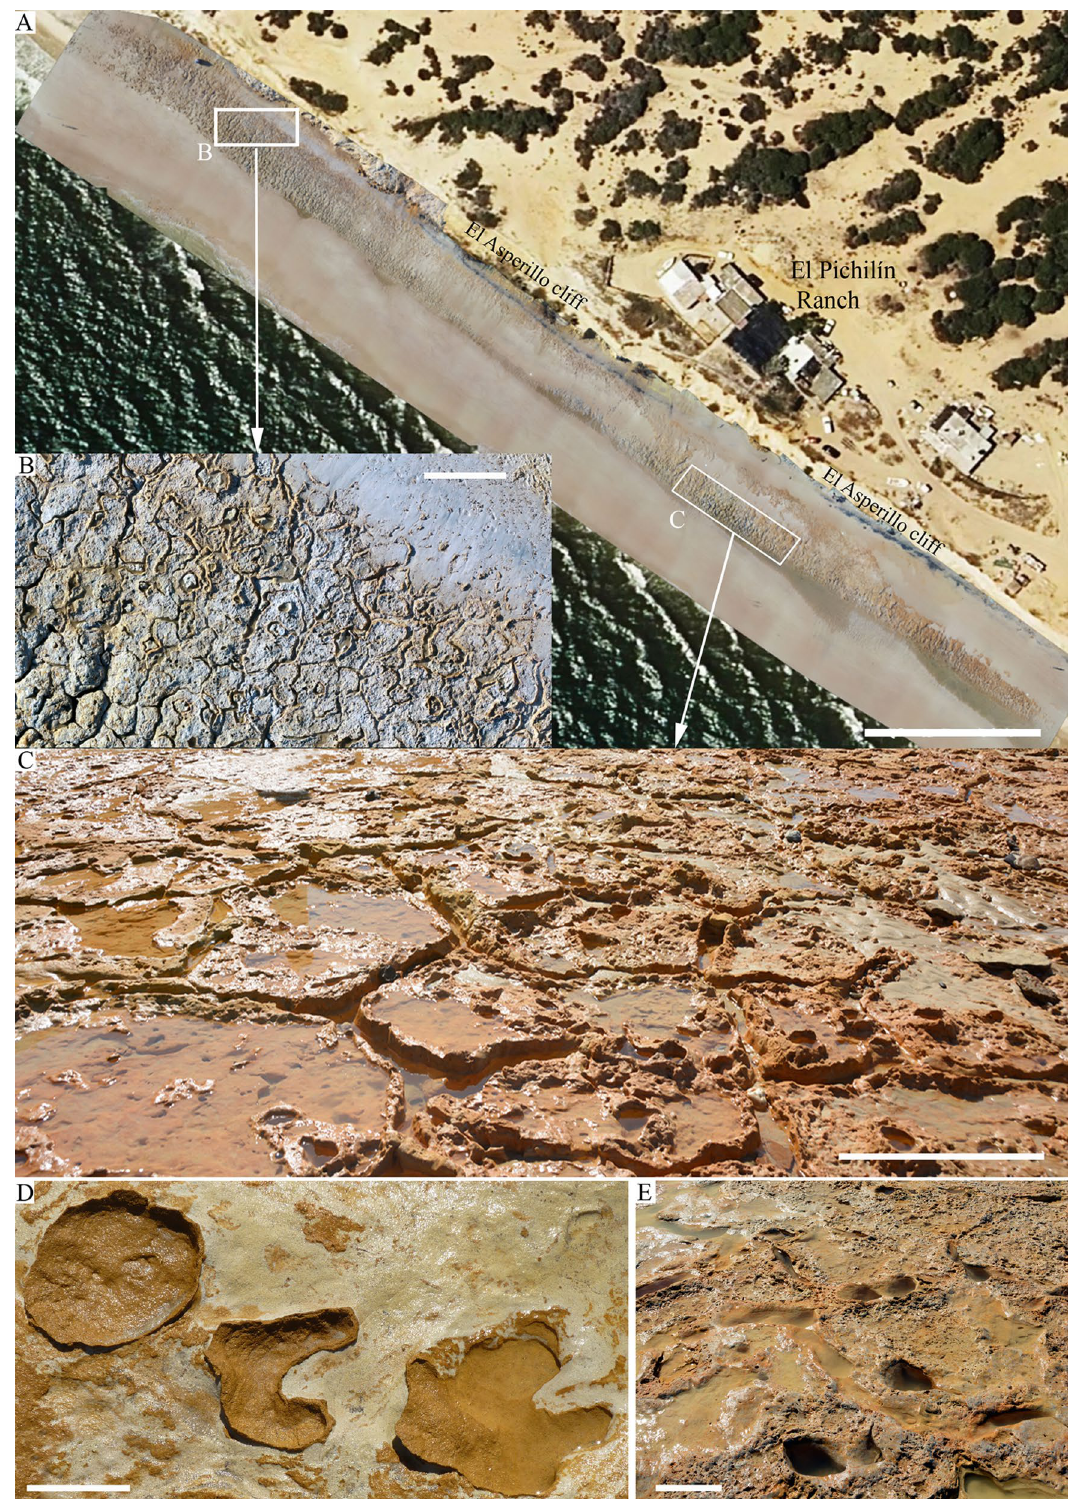
Figure 7. Current intertidal zone in the area surrounding El Pichilín, Castilla beach, Matalascañas. ( A ) General view of the cut-wave platform. Scale bar: 50 m. The polygonal mats with upturned margins of individual polygons show an extensive open cracks network resulting in the saucer-shaped polygons. Locally, subcircular openings with upturned and curled margins of the thin mat can also be seen. ( B ) Detail of the NW sector. Scale bar: 2 m. ( C ) Detail of the SE sector. Scale bar: 1 m. ( D ) Cervipeda and undetermined tracks were preserving remains of the microbial mat trapped under their footprints. Scale bar: 8 cm. ( E ) Hominin footprints preserved on the polygonal mats. Scale bar: 20 cm. The photogrammetric orthomosaic ( A ) was produced using Pix4DMapper© (versión PIX 4D Cloud, https:// www. pix4d. com/). ( A ) was obtained by a low-altitude programmed flight using an Unmanned Aerial Vehicle (UAV) on June the 12 ht , 2020, 12 AM UTC. Photograph was collected by a multirotor DJI Phantom 4 + with a 4 k 20 Mpix RGB CMOS camera at an average height of 50 m above the